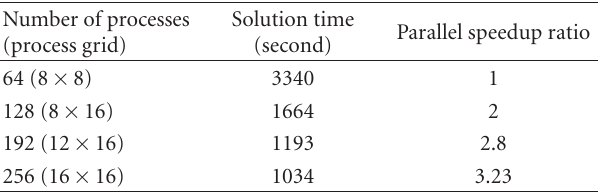
Table 5: Comparison of the simulation time of missile’s RCS with respect to